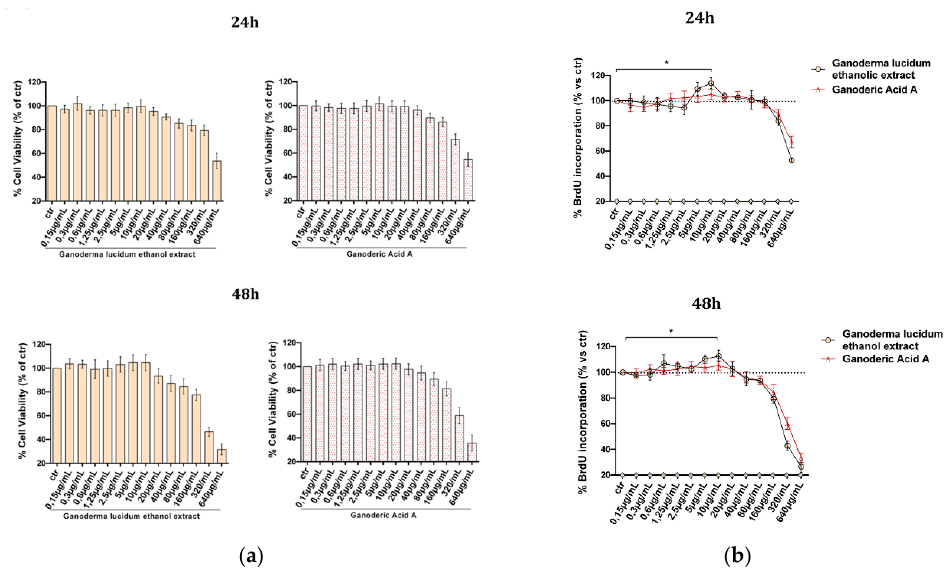
Figure 2. Evaluation of the G. lucidum extract effect in HaCaT cells: HaCaT cells were cultured for 24 or 48 h in the presence of the indicated concentrations (0–640 µg mL − 1 ) of the G. lucidum extract or ganoderic acid A before MTT assay ( a ) or BrdU incorporation ( b ). The results are expressed as means ± SD of independent experiments performed in triplicate and str reported as percentage vs. the untreated control (ANOVA, * p < 0.05 vs. control).